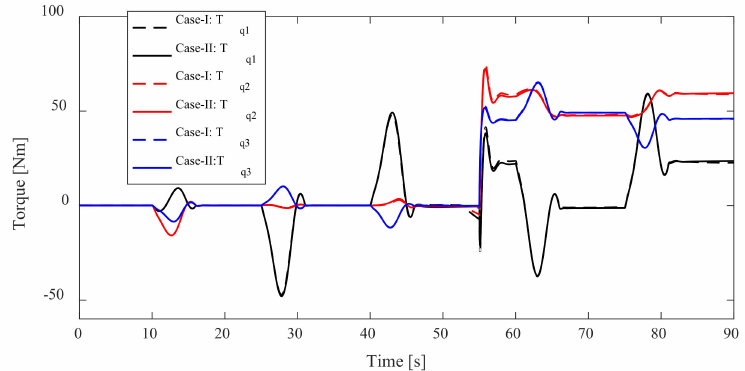
Figure 18. Joint torques of the